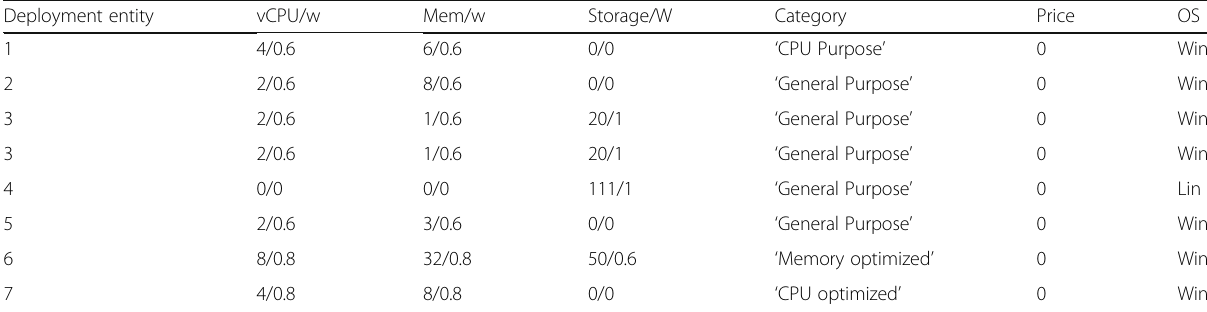
Table 3 System requirements of tested application and the assigned weight for the requirement